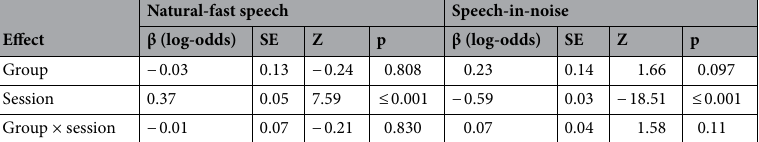
Table 2. Natural-fast speech and speech-in-noise perception as a function of group and